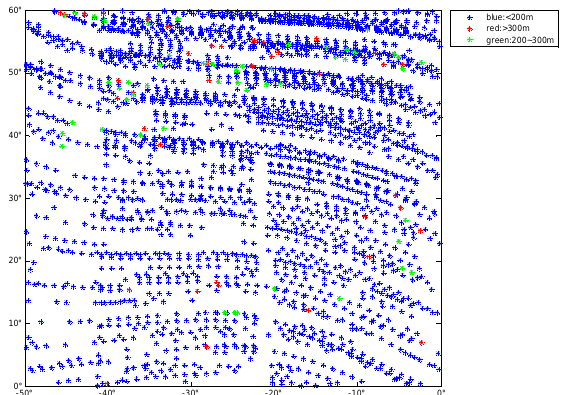
Figure 4. Distribution of crossovers in a local area (0 ° N~60 °